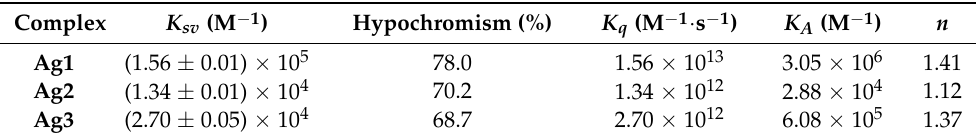
Table 5. Values of the binding constants of complexes Ag1 – 3 with BSA.